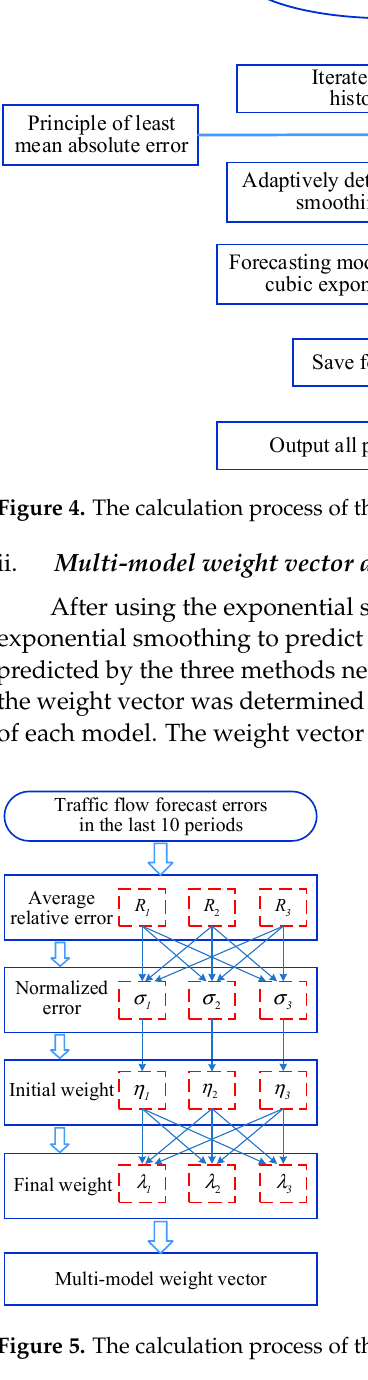
Figure 4. The calculation process of the adaptive exponential smoothing.